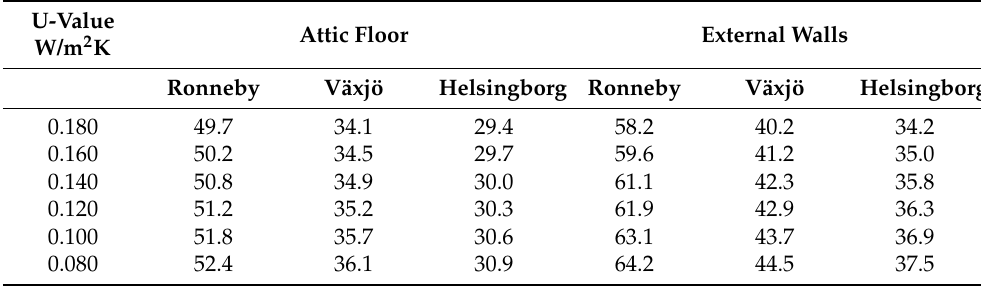
Table 10. Primary energy savings (kWh/m 2 /year) of extra insulation on the attic floor and external walls under different scales of district heating